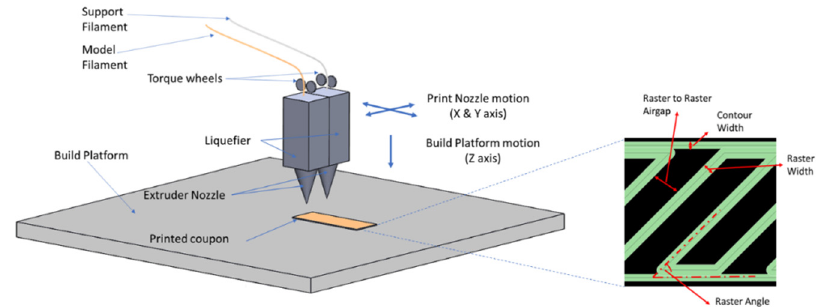
Figure 1. Principle of fused filament fabrication.